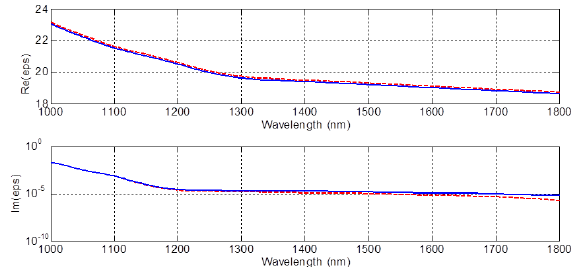
Figure 8. Experimental [9] and fitted Lorentz-Drude model for the real and imaginary parts of the silicon permittivity in the third sub-band where the imaginary part is plotted log scale.